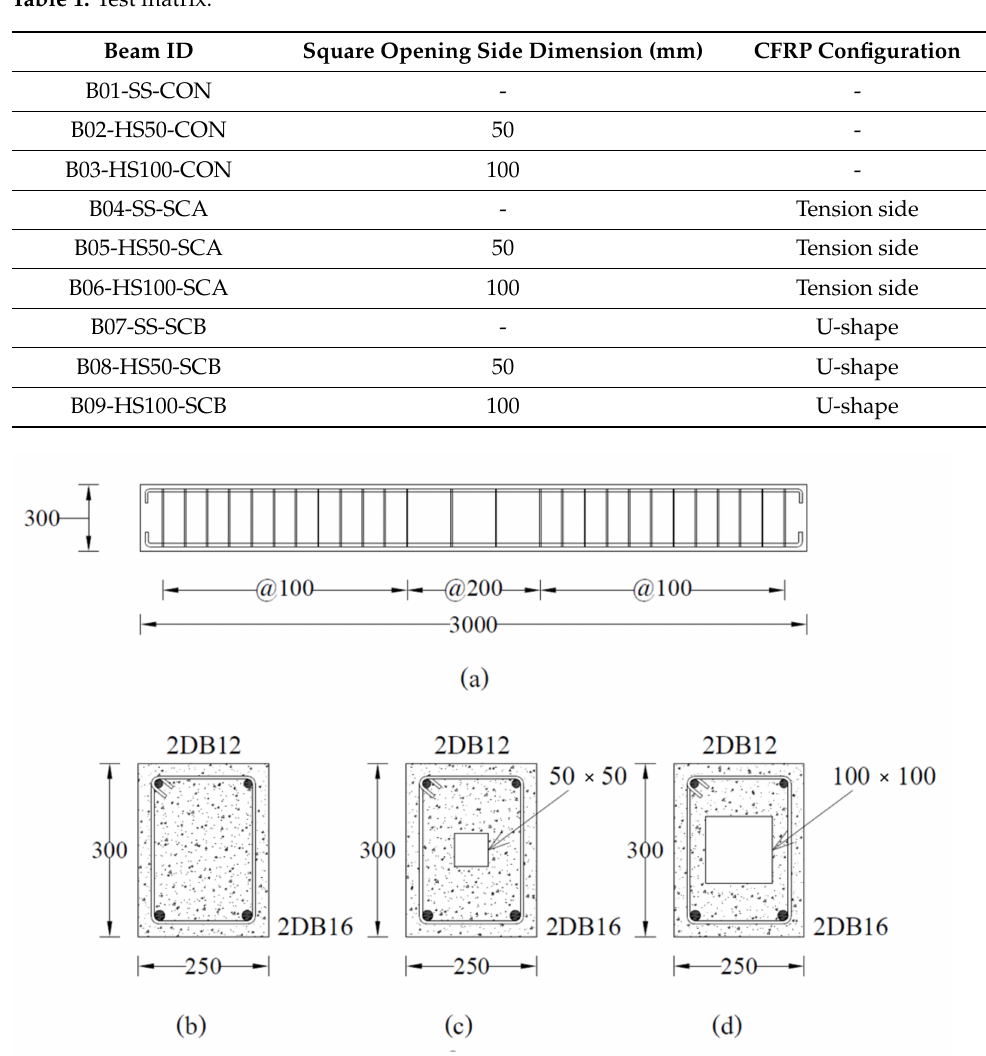
Figure 1. Typical beams in each group ( a ) longitudinal section, ( b ) solid section, ( c ) hollow section HS50, ( d ) hollow section